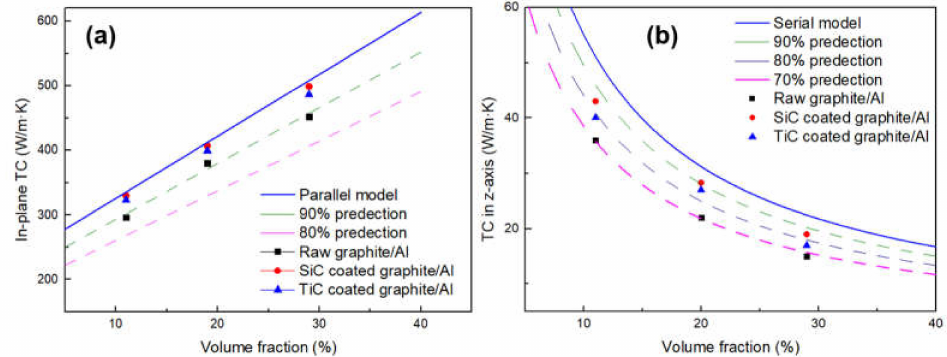
Figure 10. Comparison of the experimental TC of the composites to the predictions by TC model of laminate composites: ( a ) in-plane direction; ( b ) out-of-plane direction. In-plane direction: Out-of-plane